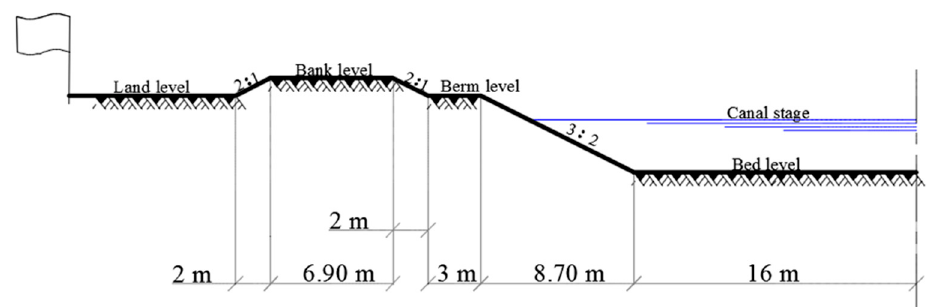
Figure 5. Schematic diagram of El-Salam Canal cross section Al-Ashaal et al. (1998) [42].